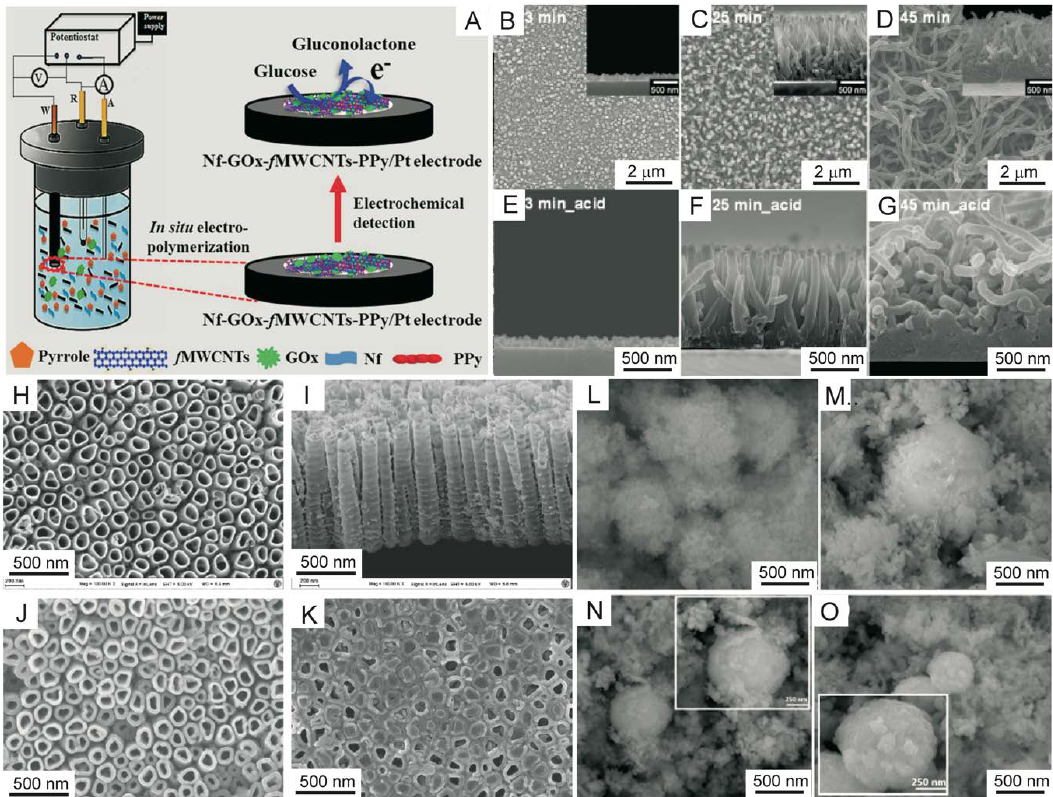
Figure 6. ( A ) Schematic illustration of glucose biosensor (Nf-GOx-fMWCNTs-PPy electrode) fabrication via a one-step in situ polymerization method [238]. ( B – D ) Planar and side direction (inset) field-emission (FE) SEM images of PPy nanostructures with different polymerization reaction times (3, 25 and 45 min, respectively) [239]. ( E – G ) Side-direction FE-SEM images of acid-treated PPy nanostructures (3, 25 and 45 min, respectively) [239]. FE-SEM images of ( H ) a top surface view and ( I ) a cross section view of a TiO 2NT array, ( J ) a top surface view of PPy/TiO 2NT and ( K ) the GOD/PPy/TiO 2NT electrode [241]. SEM images of ( L ) Co 3 O 4 and ( M – O ) Co 3 O 4 /PPy composites with different concentrations of PPy (5, 20 and 40%) [242]. Abbreviations: Nf (Nafion); f MWCNTs (functionalized multi-walled carbon nanotubes). Reprinted with permission from References [238,239,241,242]. Copyright 2019 Nature Group, American Chemical Society and Elsevier.